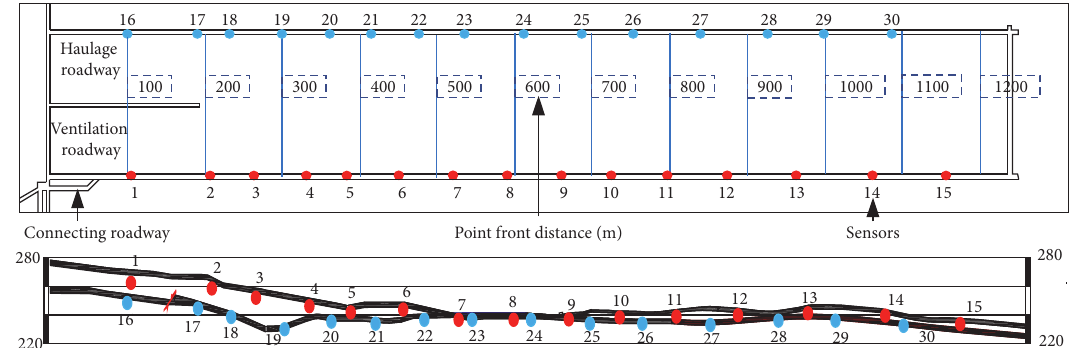
Figure 1: The flat profile projection of the working face sensor